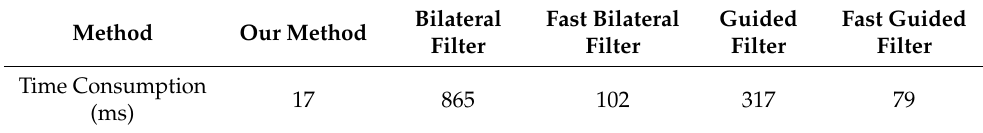
Table 2. Average processing time of different filtering algorithms.